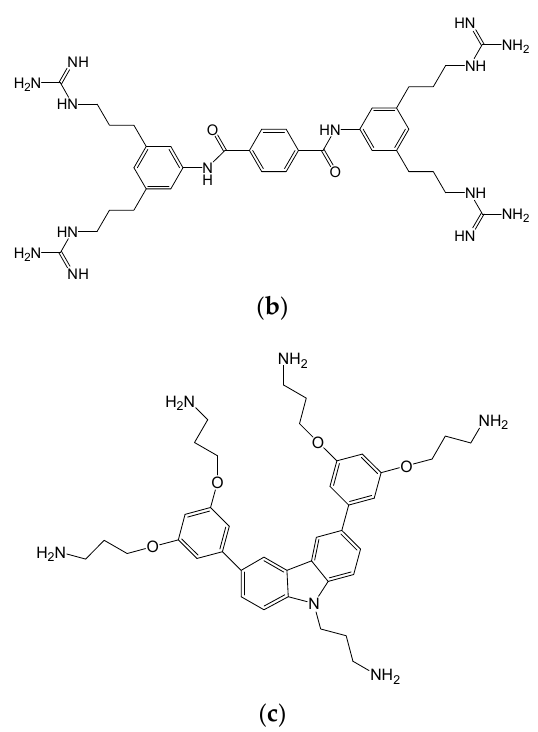
Figure 1. Representative compound structures. Structures of Compounds 1 ( a ), 2 ( b ) and 4 ( c ), corresponding to triacyl, bis-amide and tricyclic structures are shown.